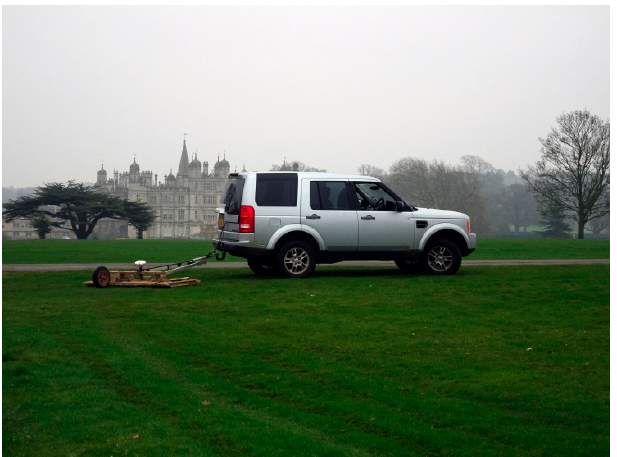
Figure 2. Vehicle towed ground penetrating radar survey in progress over the site of the competition arena with Burghley House in the background. The 20 channel GPR array is towed behind the vehicle with measurements triggered every 0.075 m by the odometer wheel and positional control provided by an RTK GNSS receiver mounted above the centre of the GPR array.